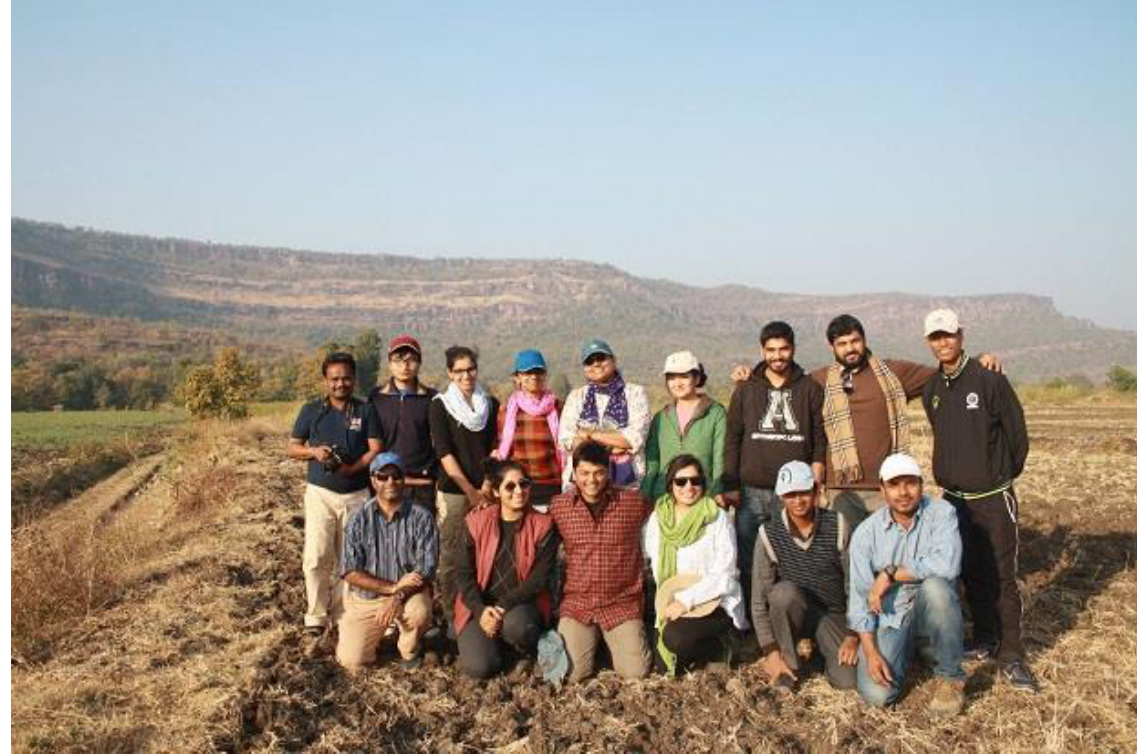
Figure 1. The participants and resource staff in the paleoanthopology